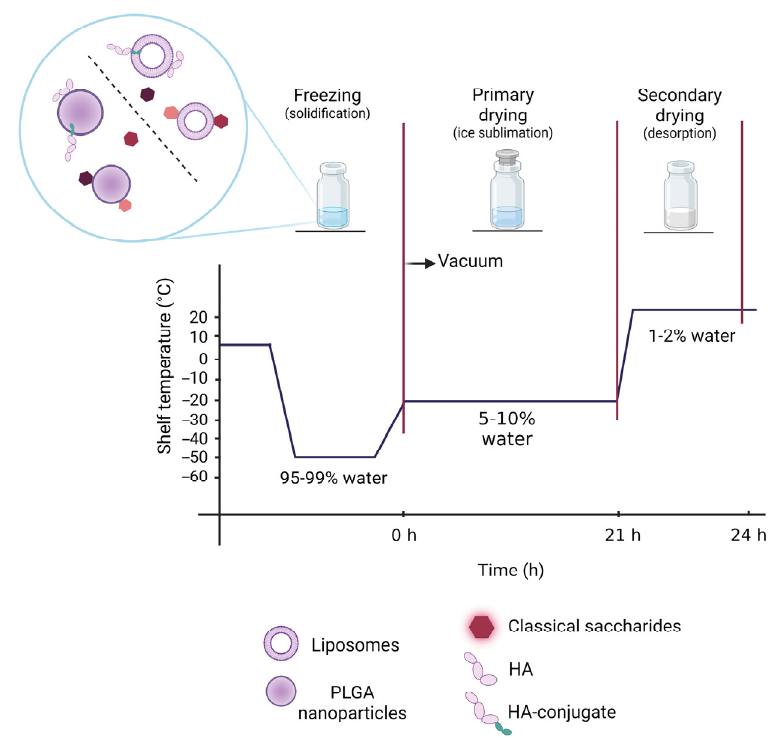
Figure 1. Schematic representation of the freeze-drying process for PLGA nanoparticles and liposomes formulated with different cryoprotectants (created with BioRender.com).